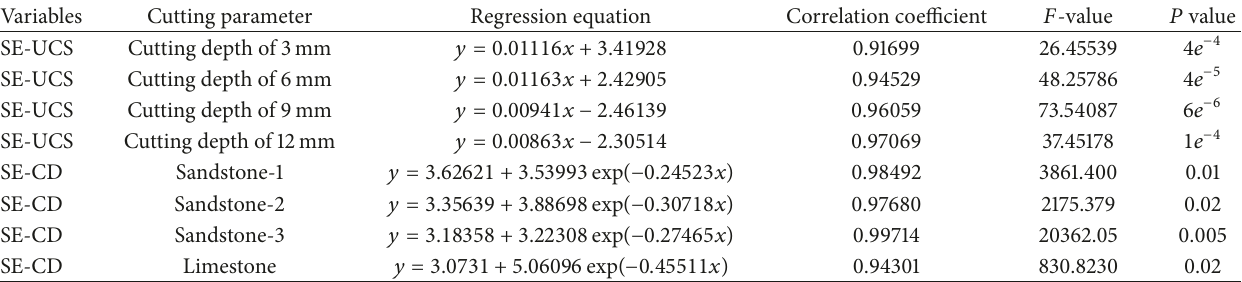
Table 7: Regression results to predict cutter